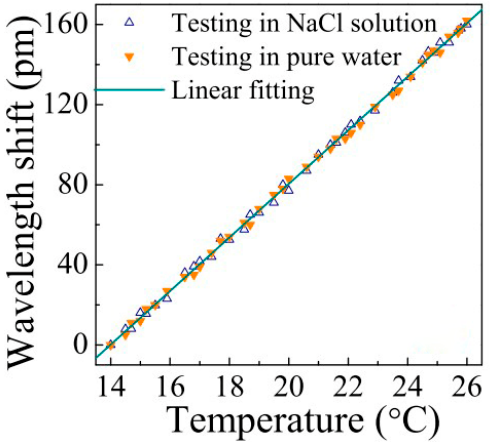
Figure 5. Relationship between the wavelength shift and temperature for different external solutions.